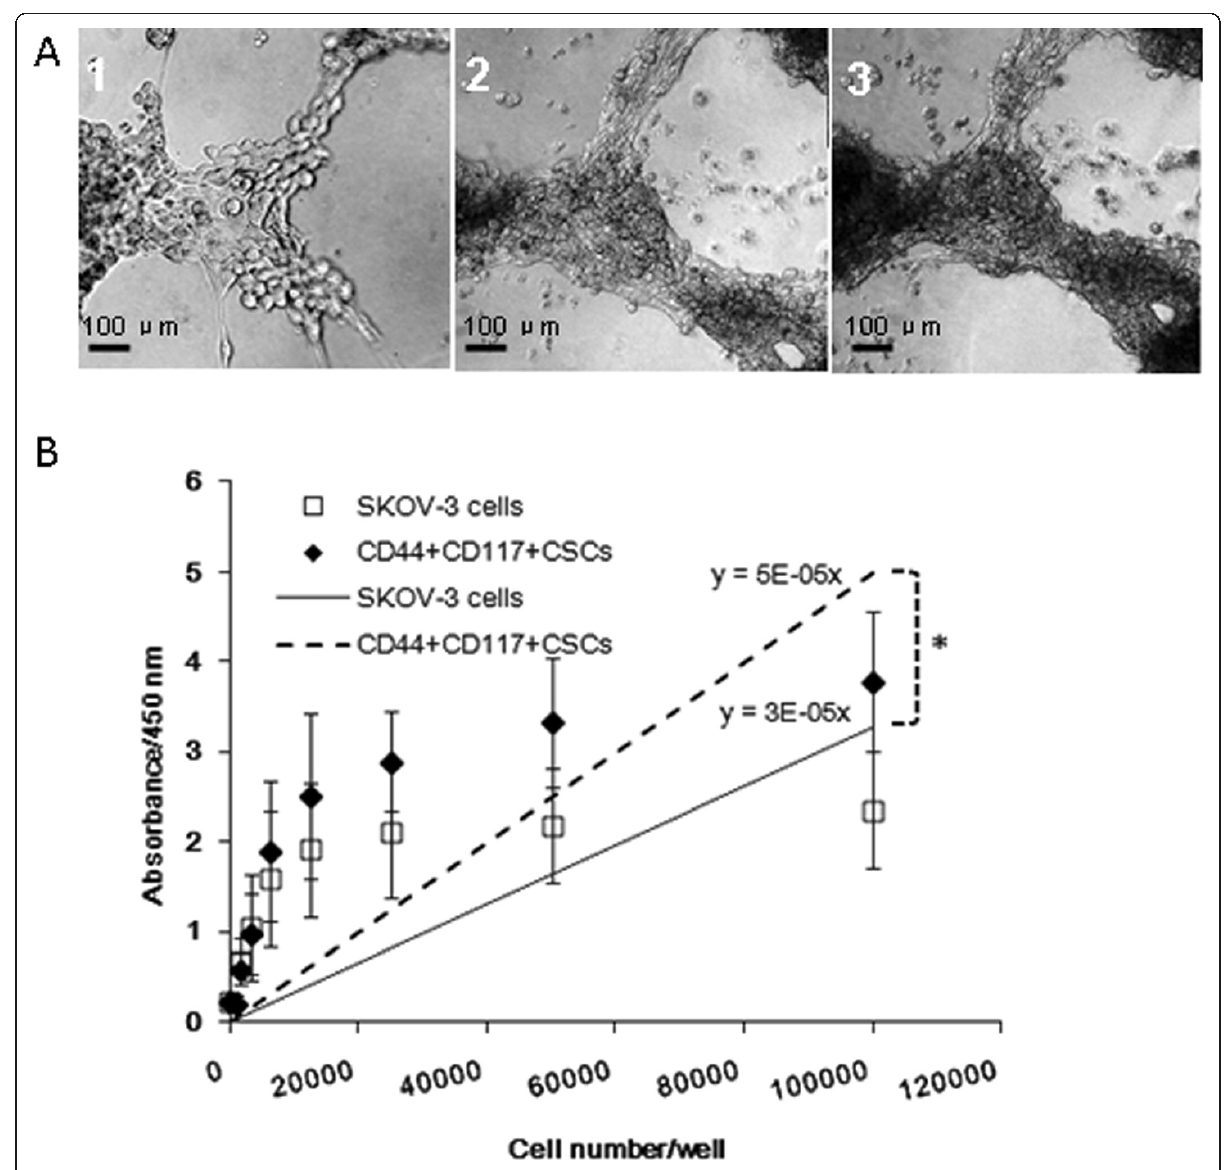
Figure 3 Cell growth in 3D BME scaffold. The CD44 + CD117 + CSCs grew more quickly in A 1(2 days), A2(4 days) and A3(6 days). 100×. B shows standard growth curves of the CD44 + 117 + CSCs and the SKOV-3 cells. Statistically significant differences are denoted by asterisk (*) for P < 0.05